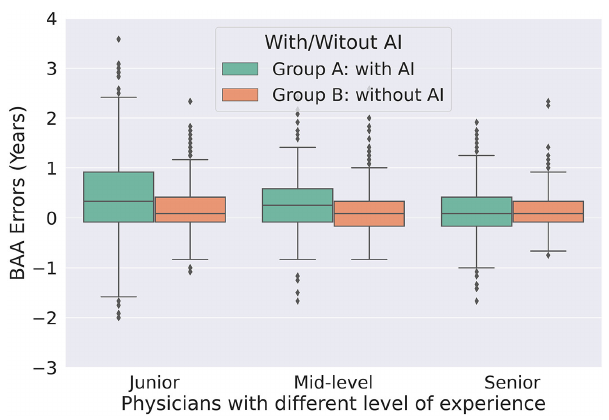
FIGURE 3 | Box plot of bone age assessment errors without AI assistance (group A) and with AI model assistance (group B) for physicians of different experience. AI, artificial intelligence; BAA, bone age